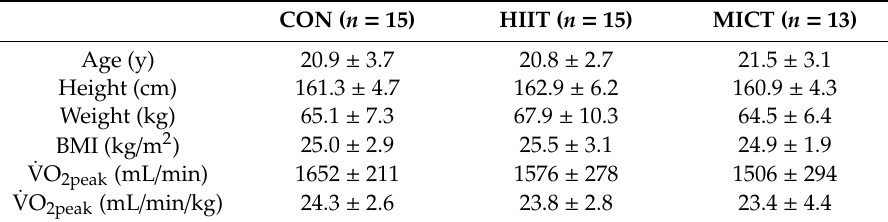
Table 1. Demographic data of the participants at